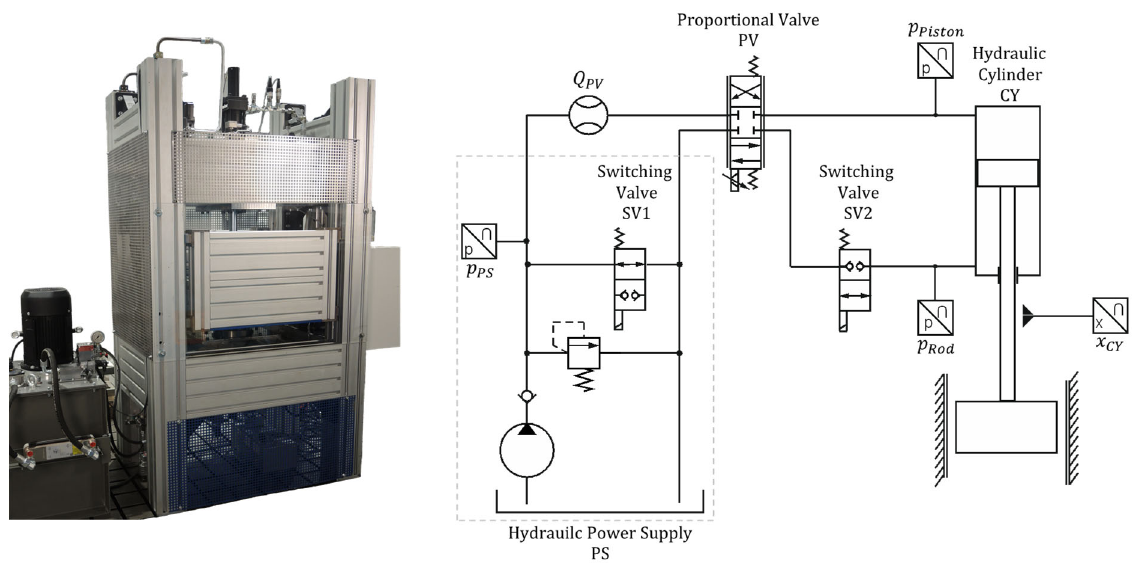
Figure 2. Hydraulic press test bench and its hydraulic circuit diagram.